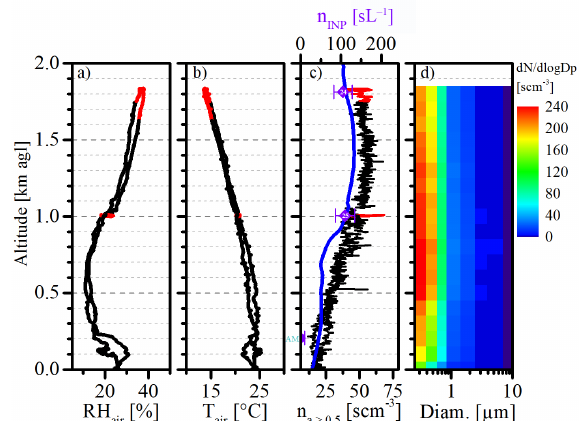
Figure 17. Vertical profiles of the first Cruiser flights on 9 April: (a) relative humidity and (b) temperature. Panel (c) shows num- ber concentration (black line) n a> 0 . 5 of particles with d > 0.5µm measured by OPC onboard UASs (lower scale) as well as INP con- centration (upper scale) derived from n a> 0 . 5 using the parameteri- zation from Fig. 12d. Blue line: n a> 0 . 5 derived from lidar backscat- ter (lower scale) as well as INP concentration (upper scale) derived from n a> 0 . 5 using the parameterization from Fig. 12d. The INP measurements at T =− 30 ◦ C of the samples 24 and 25 are given by purple diamonds; data from the ground station are labeled with AM. Altitude is given in meters above ground level relative to the location of the UAS airfield (327ma.s.l.). The INP sampling inter- val is indicated in red. Panel (d) shows that the average aerosol size distribution is binned into 100m intervals.